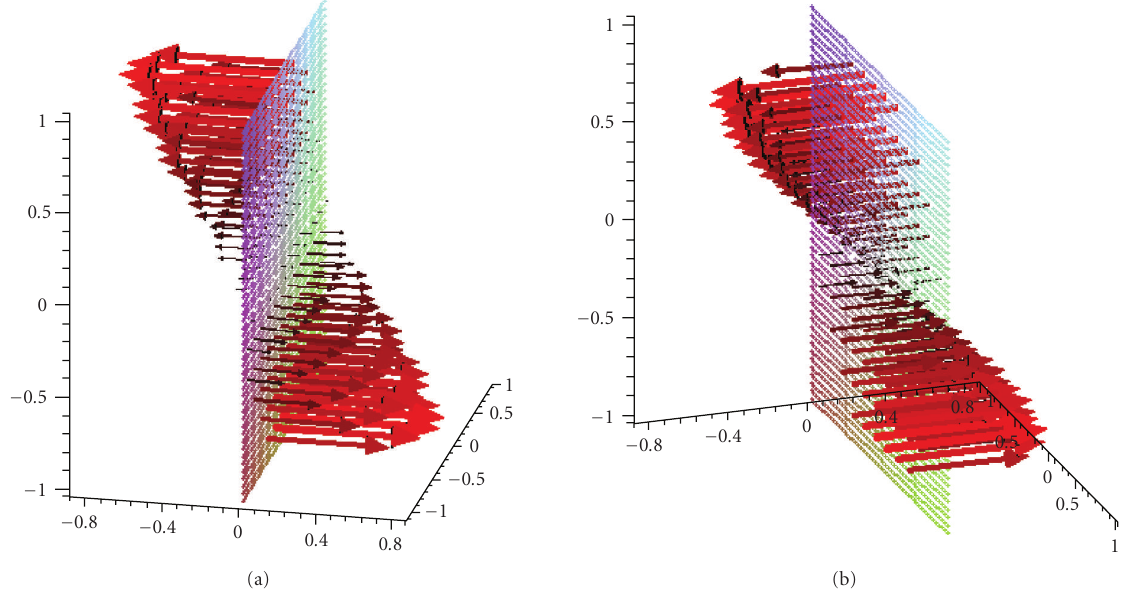
Figure 10: Reconstruction of the vector field f ( x ) = ( − x 2 , x 1 ,0) (cid:9) with the described algorithm for γ = 0 . 00692 in the plane { x 1 = 0 }